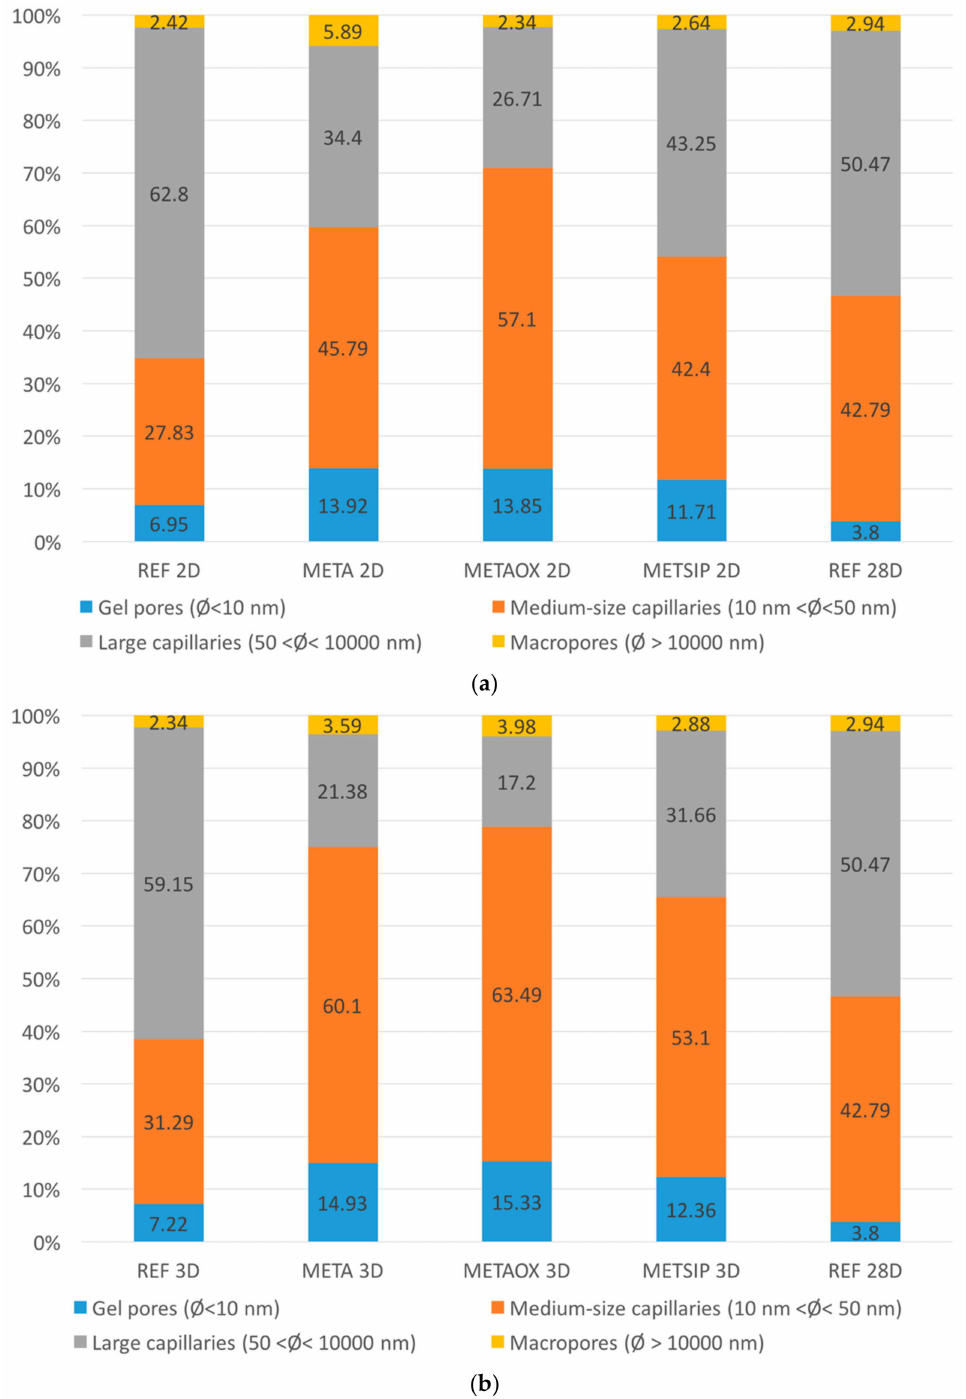
Figure 4. Pore size distribution of mixes with combined nanosilica and metakaolin at early ages and pore size distribution of reference mortar at 28 days. Distribution at ( a ) two days and ( b ) three